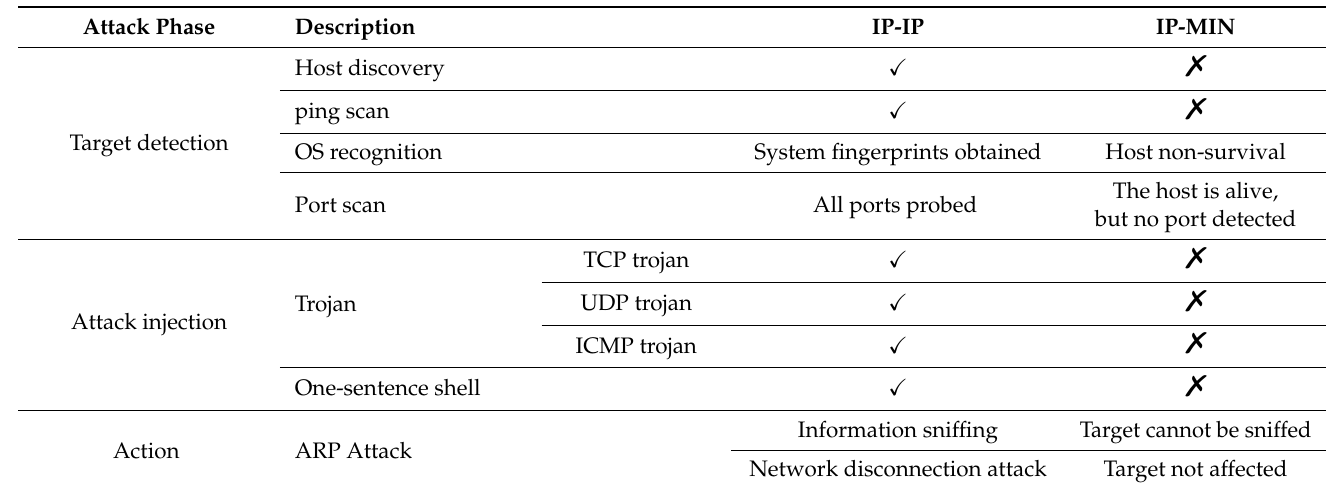
Table 1. Attack results of experiments.